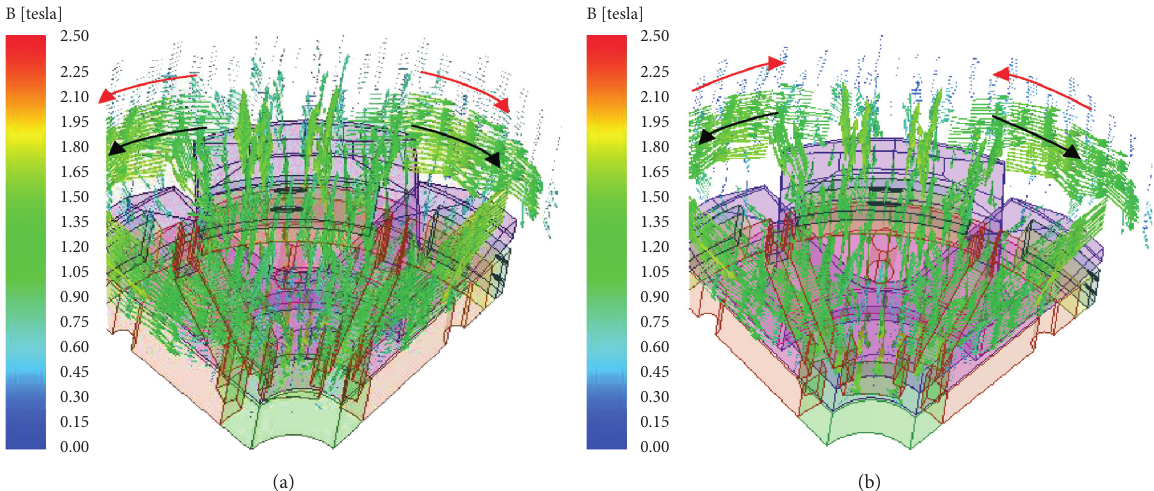
Figure 12: The flux density vector diagram with different excitation currents. (a) With forward current. (b) With reverse